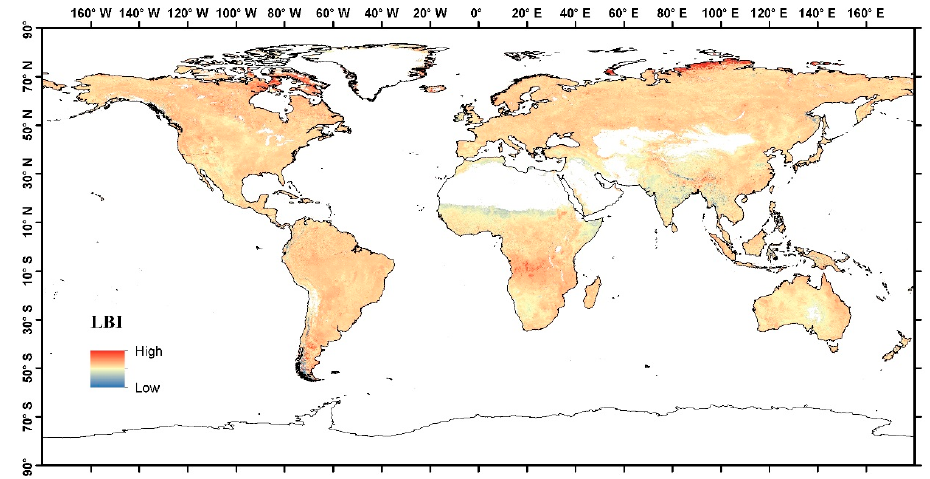
Figure 8. LBI values for July 2008. Higher LBI values were observed in the Southern Hemisphere